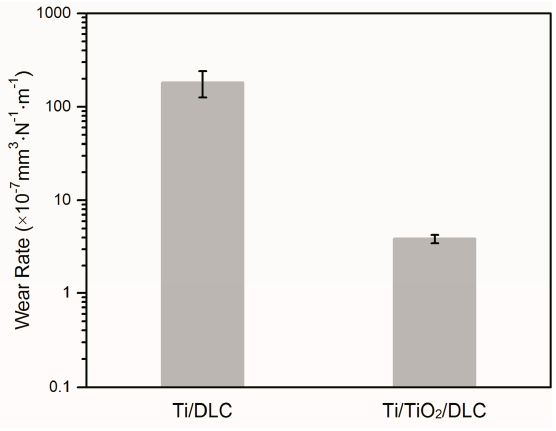
Figure 7. Wear rate of samples under normal load 10 N.